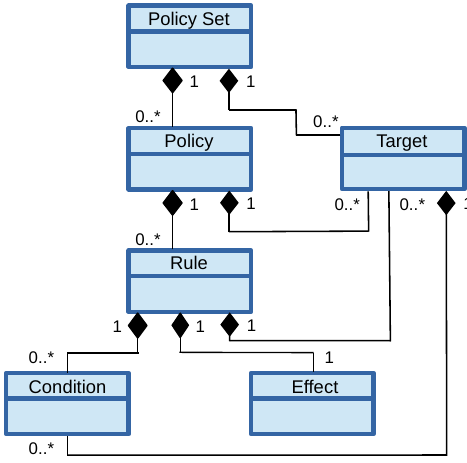
Figure 6. Metamodel of authorization policy